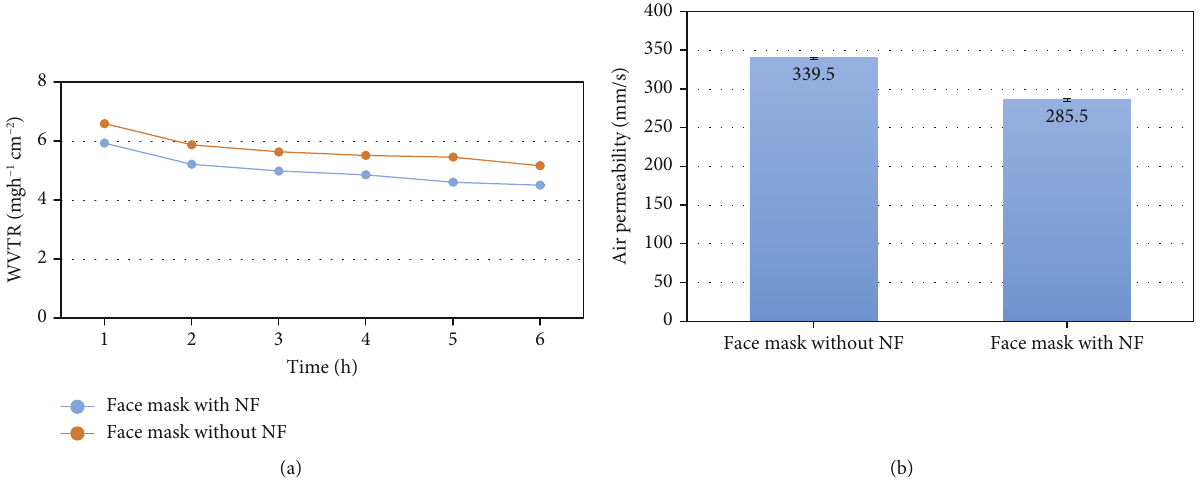
Figure 3: (a) Water vapor transmission rate (WVTR) and (b) air permeability of a surgical face mask with and without electrospun nano fi ber (NF) inserts. The WVTR error bars were neglected due to a low